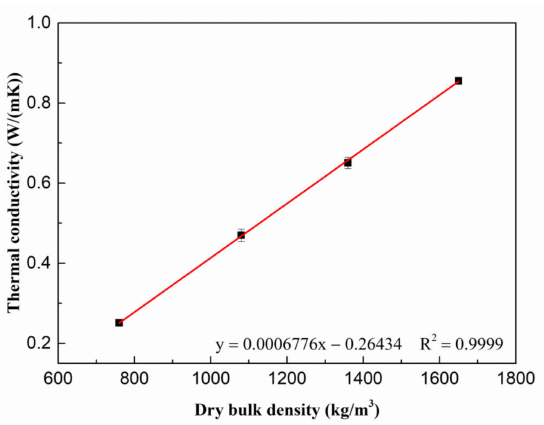
Figure 15. Relationship between thermal conductivity and dry bulk